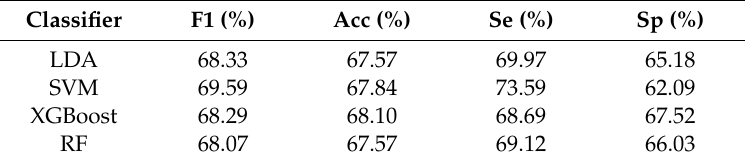
Table 2. Comparison of performance of di ff erent classifiers without feature